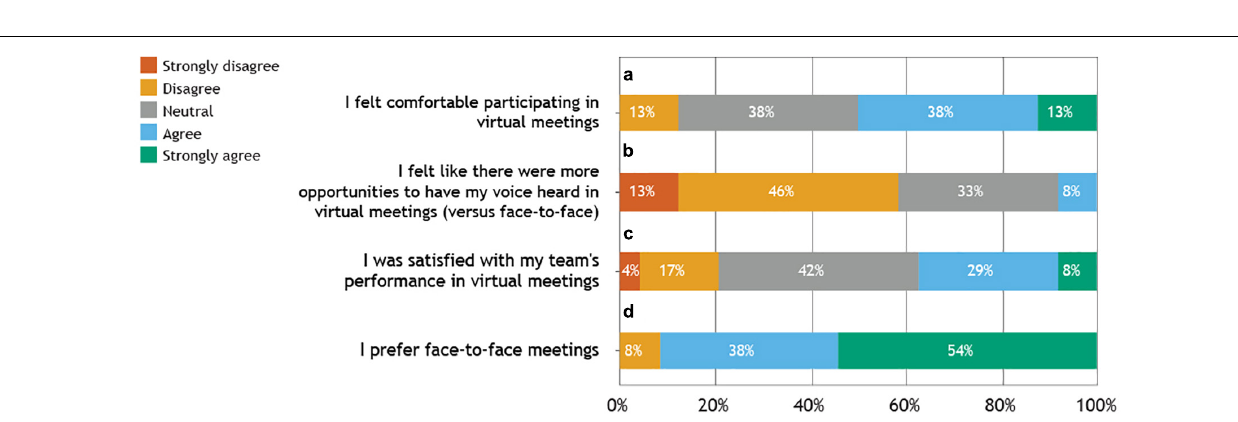
region in general. In terms of the appropriateness of virtual respondents (58%) felt that virtual formats are inappropriate for